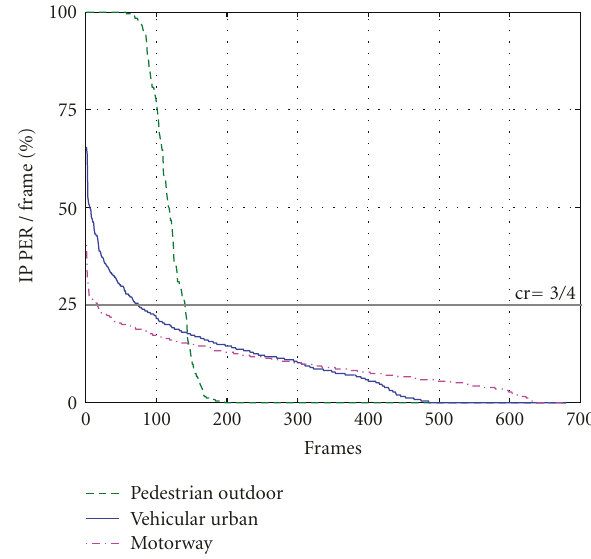
Figure 5: IP packet error ratio for each MPE-FEC frame in di ff erent channel conditions